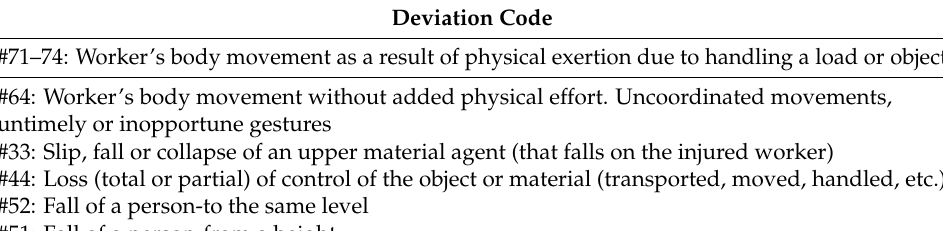
Table 2. Description of the Deviation Codes and Physical Activity